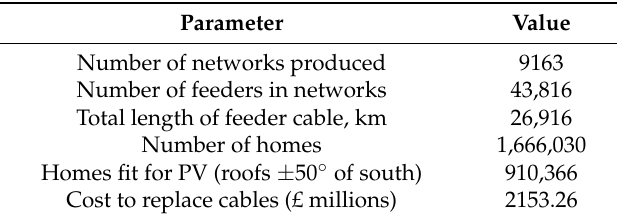
Table 2. Summary of networks analysed.